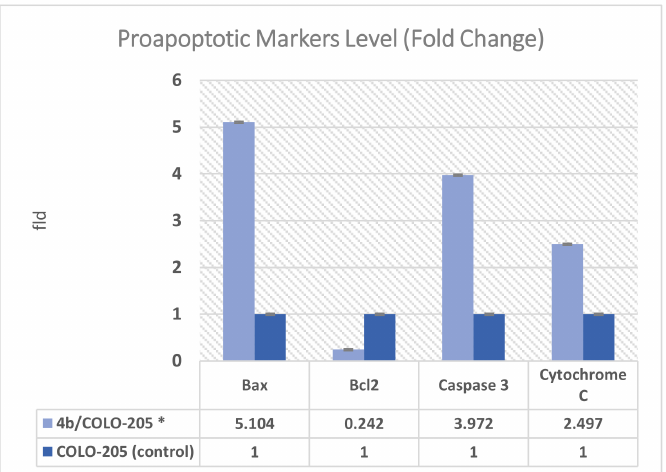
Figure 4. Bax, Bcl-2, Caspase 3 and Cytochrome C expression levels in COLO-205 cells treated with compound 4b (light blue) or DMSO (dark blue) as control. * Data obtained from this group are significantly different from control with two-tailed p value less than 0.0001.